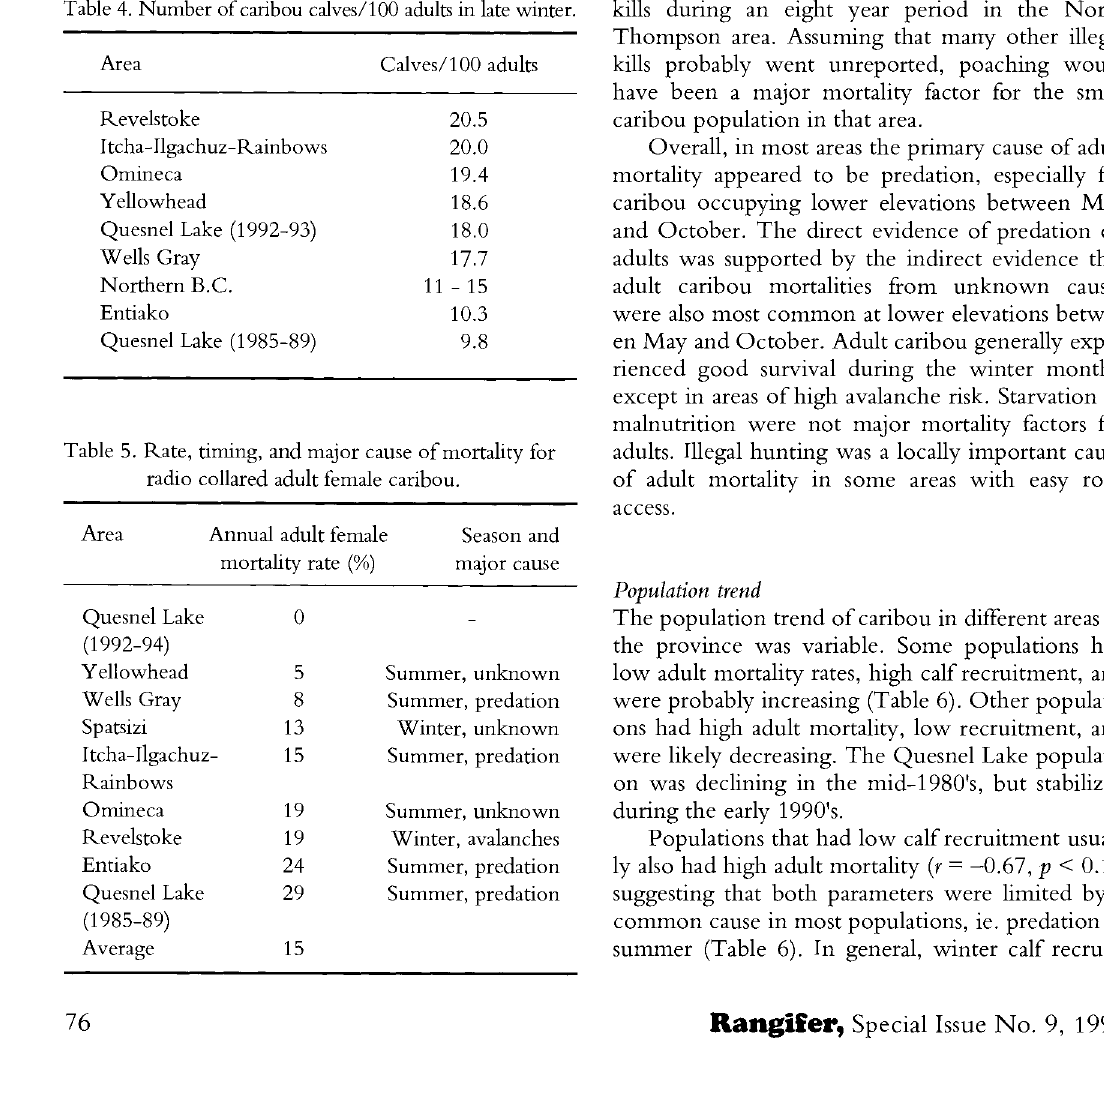
Table 4. Number of caribou calves/100 adults in late winter.